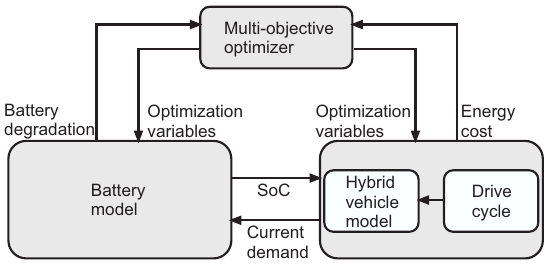
Figure 2. Optimization of battery charge patterns (according to